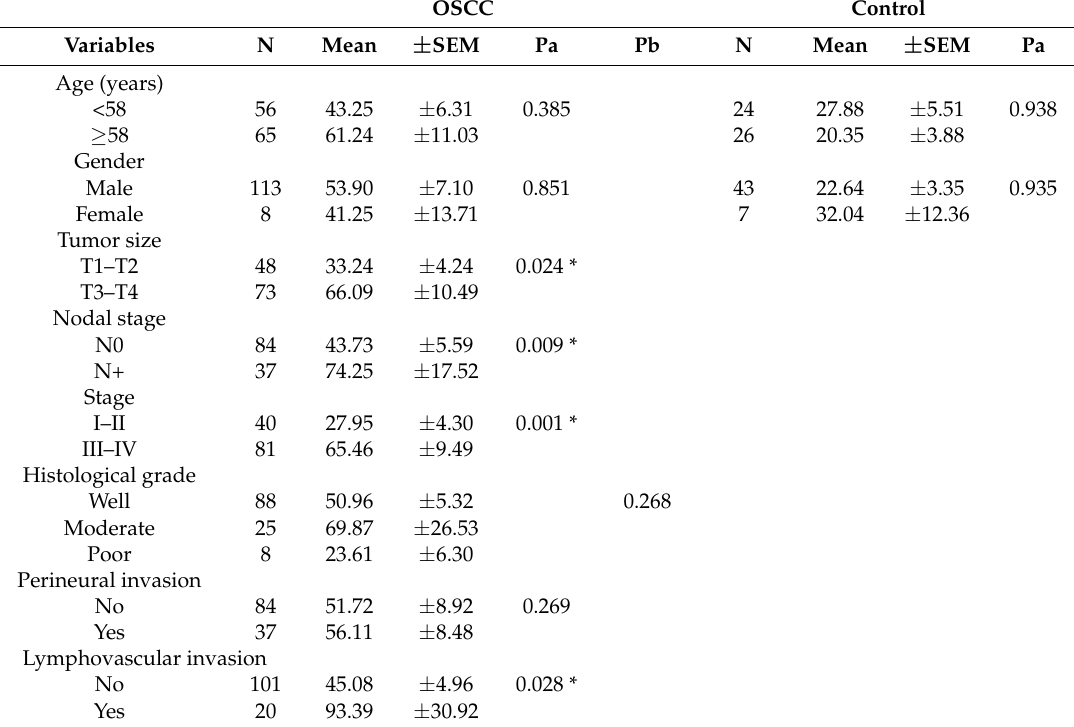
Table 1. Clinical parameter and cfDNA content in OSCC patients.